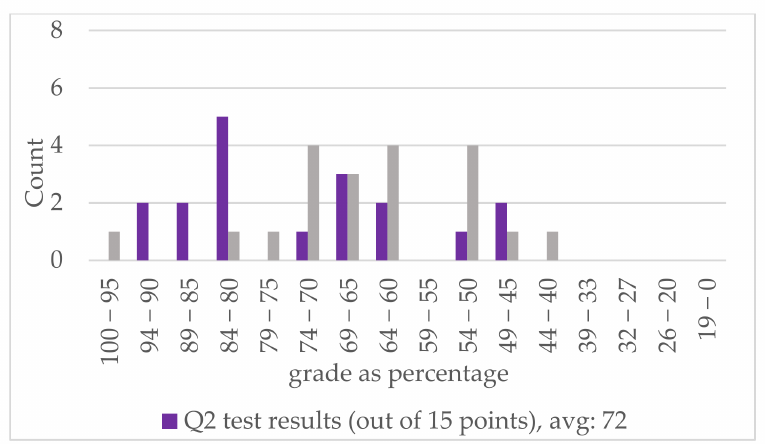
Figure 22. Comparison of the grades of the Q2 class between the evaluation results and the written grades they achieved in the same